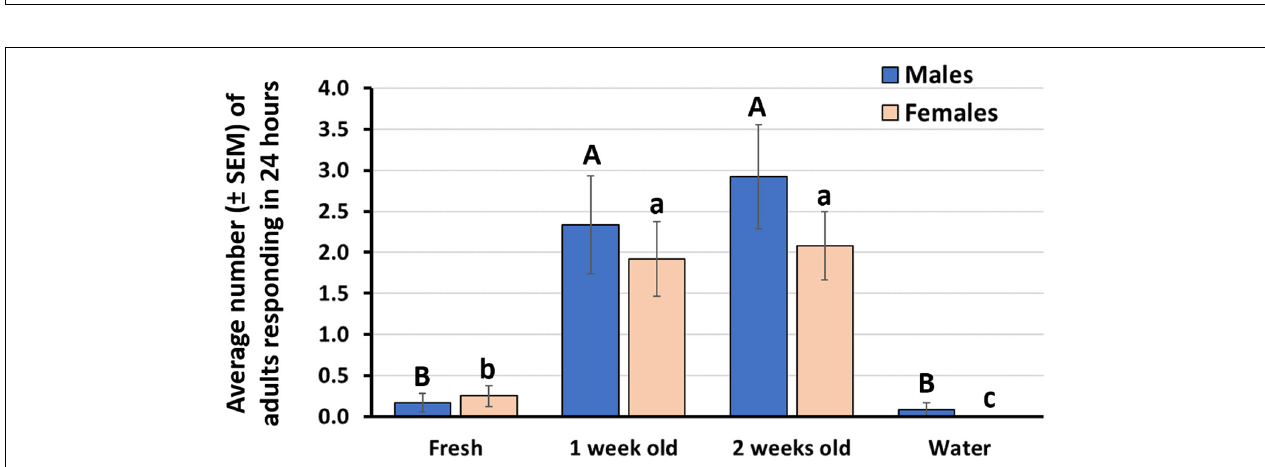
FIGURE 3 | Early season captures (means ± SEM) of (A) male and female D. suzukii and (B) other drosophilids, in traps baited with fresh diluted Concord grape juice (DGJ) and four commercial lures. Study conducted in four Massachusetts locations from 11 May to 7 July 2020. For non-target insects, means superscribed by different letters denote significant differences according to ANOVA and HSD Tukey tests at P = 0.05.